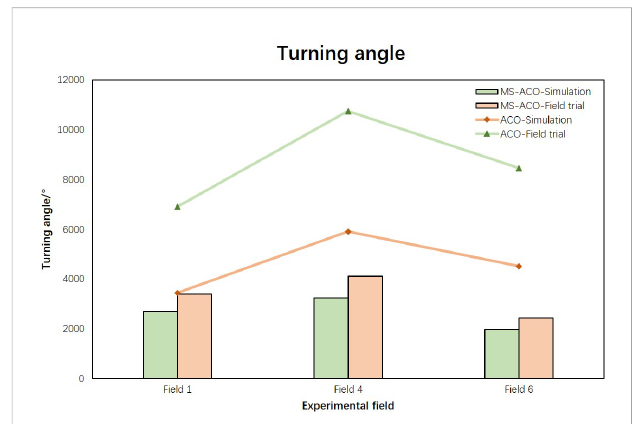
FIGURE 10 Comparison of corner results between simulation experiment and fi eld